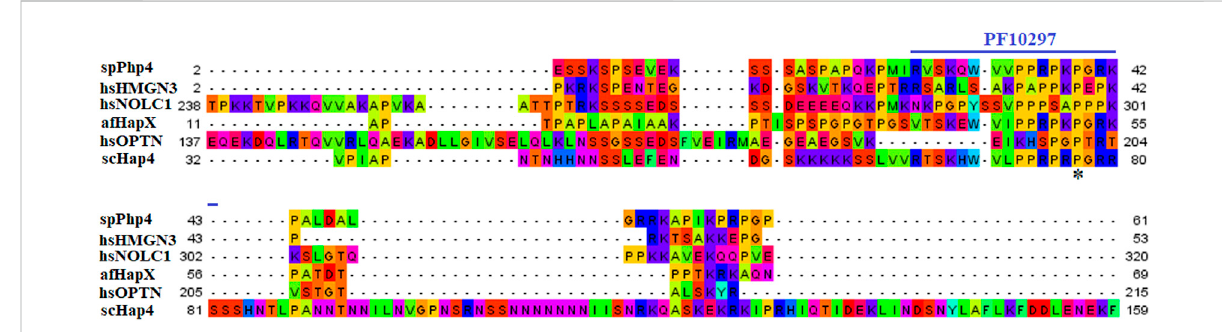
FIGURE 6 Multiple sequence alignment of sequences of the PF10297 domain in spPhp4 and its homologs in A. fl avus , S. cerevisiae and humans. The domain was discovered through a search of the SMART database. They are highlighted according to the biochemical properties of the amino acid